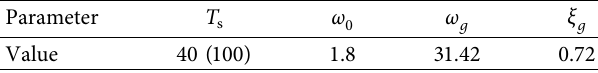
Table 1: Values of parameters of Du and Chen